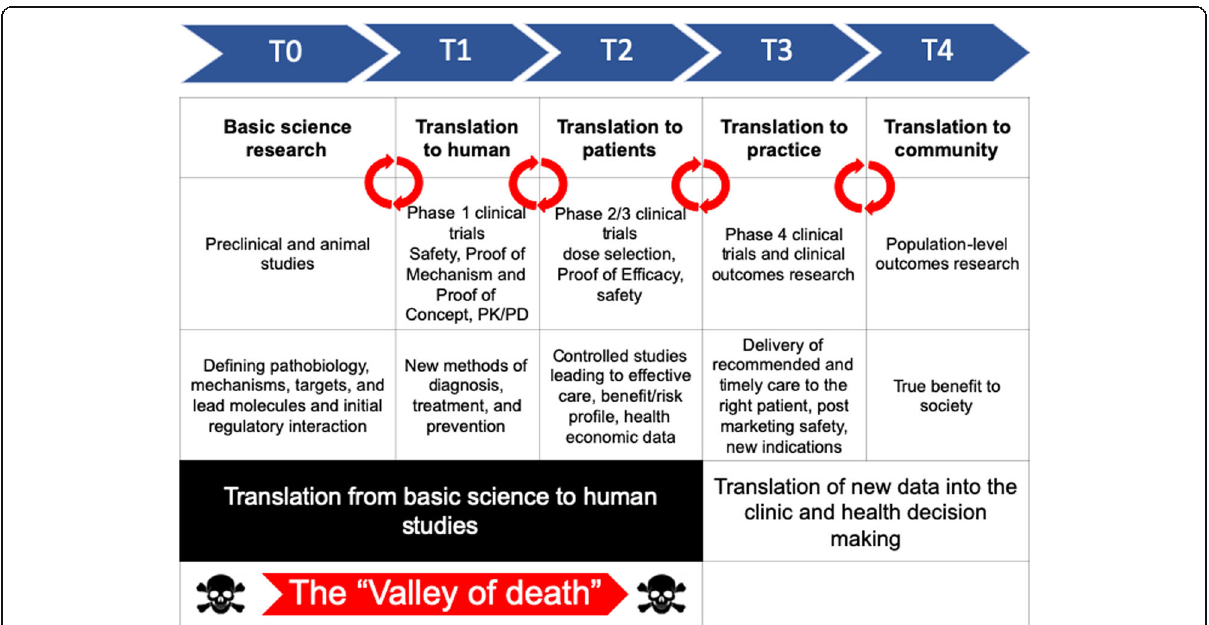
Fig. 1 Operational phases and associated challenges for translational research. Translational research has many layers (T0-T4) and associated operational obstacles that must be overcome. T0, basic science research that define cellular mechanisms, their relationship to disease and, consequently, the identification of therapeutic targets and development of methods of treatment (new molecular entities). T1, is the proof of concept studies conducted in volunteer human subjects as phase 1 clinical trials that aim to define proof of safety, mechanism, and concept. T2, phase 2 and 3 clinical (ideally randomized) trials that are necessary to test the proof of efficacy of the therapeutic agent in cohorts of patients representing the relevant disease that may include control groups. T3, phase 4 clinical trials that are associated with optimizing the therapeutic use of a therapeutic agent in clinical practice. T4, Population-level outcomes research or comparative effectiveness research aims to determine the ultimate utility and